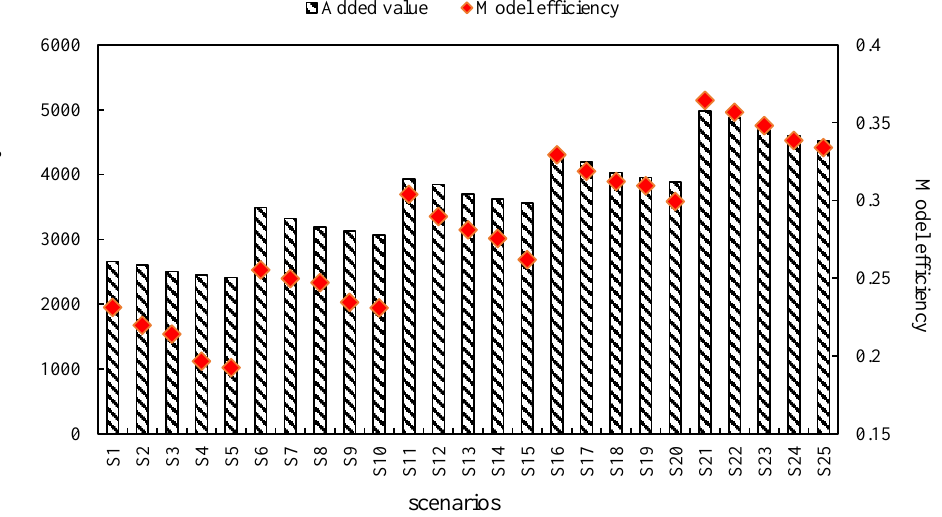
Figure 6. Added value and model efficiency under different scenarios.